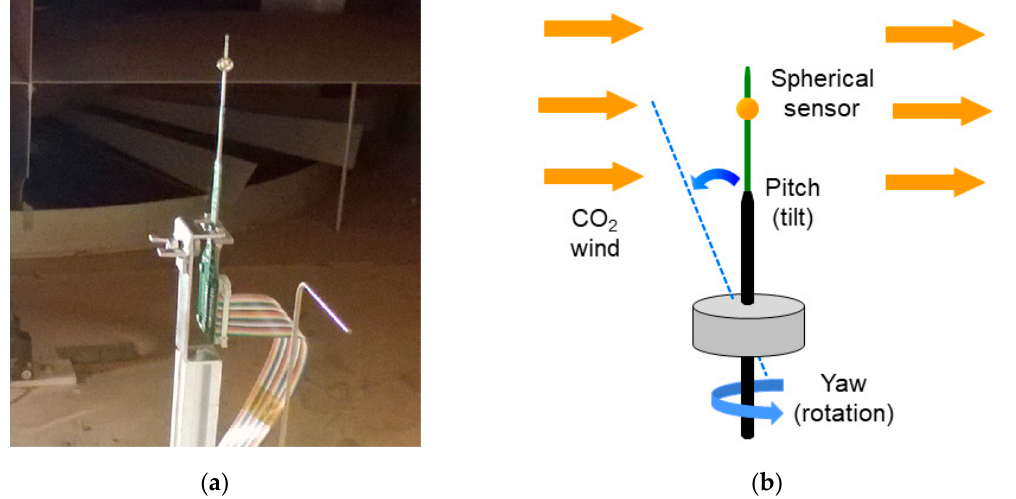
Figure 5. ( a ) Sensor support and orientation structure used in the AWTSII experiments; ( b ) Reproducing 3D wind direction through sensor